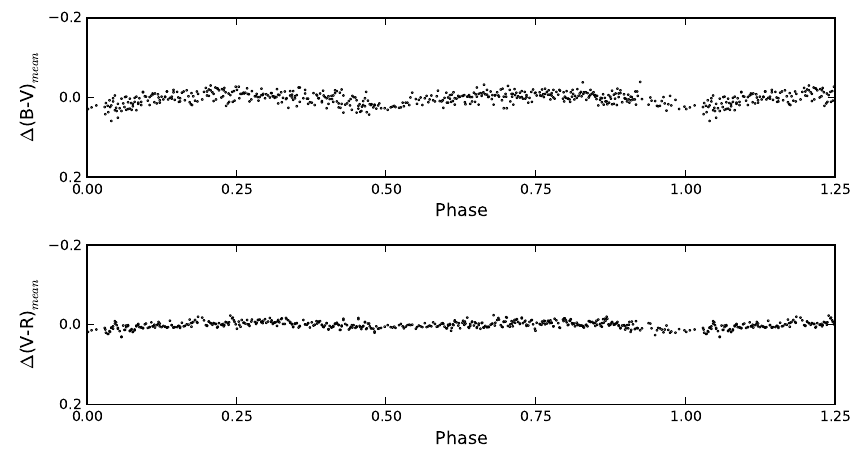
Fig. 3. Color curves B – V and V – R for BB Peg. The mean color values have been subtracted to better illustrate the variation. Light level difference of the secondary maxima (phase 0.75), being lower